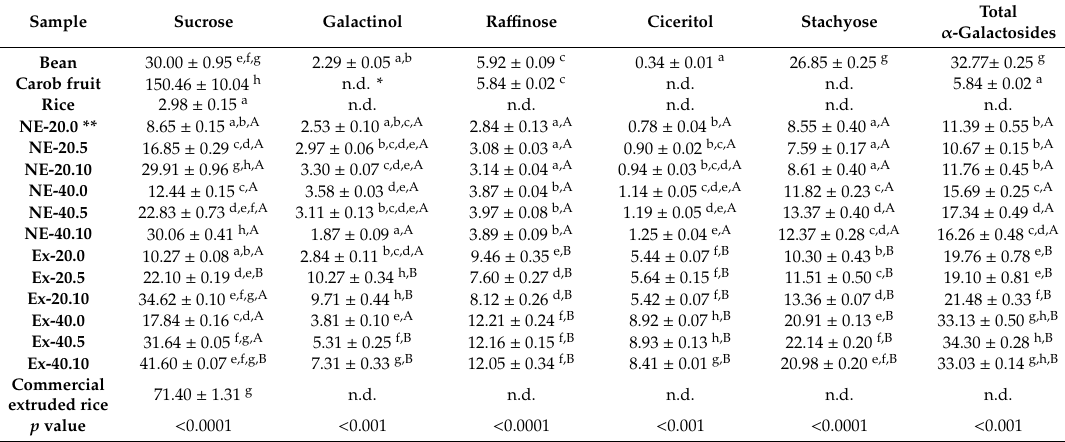
Table 1. Effect of extrusion treatment on the soluble sugars, ciceritol, and α -galactosides (mg / g dry weight) content of raw materials, the non-extruded (NE-) and the extruded (Ex-) flour formulations, and the commercial